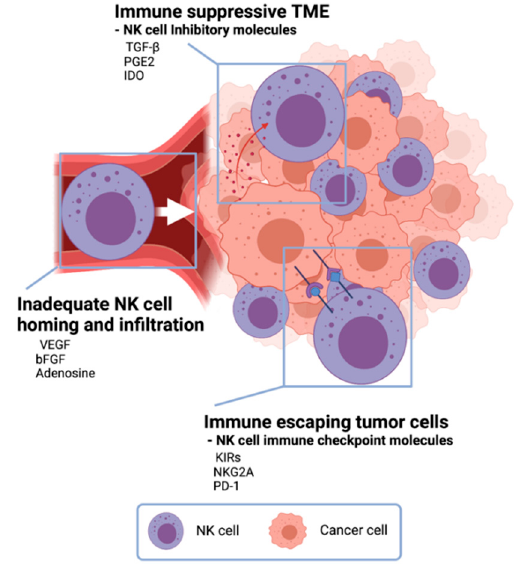
Figure 3. Challenges in NK cell cancer immunotherapy. In the tumor microenvironment, cancer cells secrete anti-immune molecules TGF- β , PGE2, and indoleamine 2,3-dioxygenase (IDO) to evade NK-cell-mediated tumor-cell lysis. Vascular endothelial growth factor (VEGF), basic fibroblast growth factor (bFGF), and adenosine inhibit NK cells from homing to tumors resulting inadequate NK cell infiltration in tumors. Tumor cells express NK cell immune checkpoint molecules to escape from NK cells.